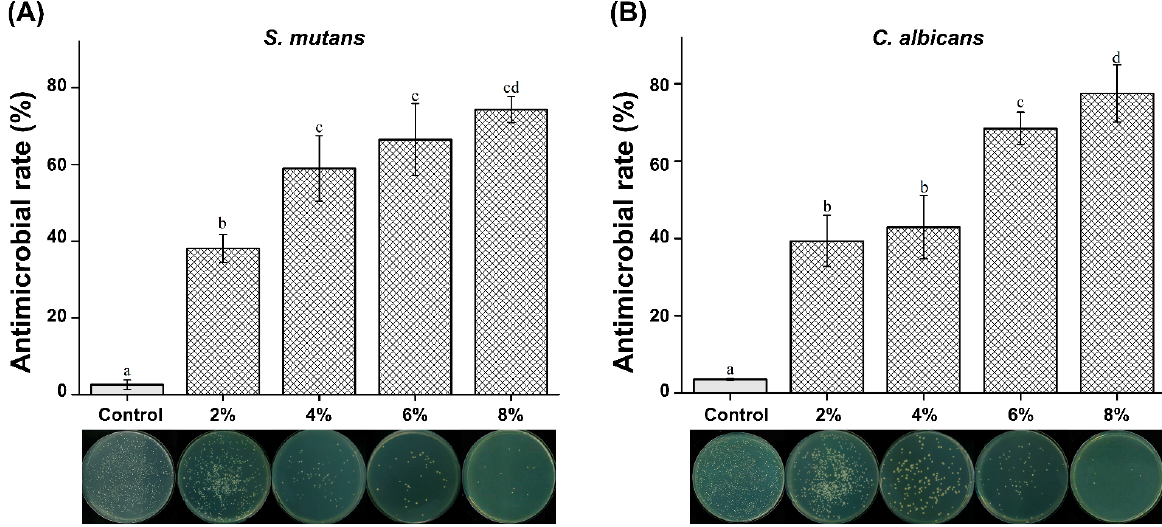
Figure 6. Antimicrobial rates of ( A ) S. mutans and ( B ) C. albicans . The same letter indicates no statis- tically significant difference (P > 0.05). Different letters indicate a statistically significant difference (P < 0.05).